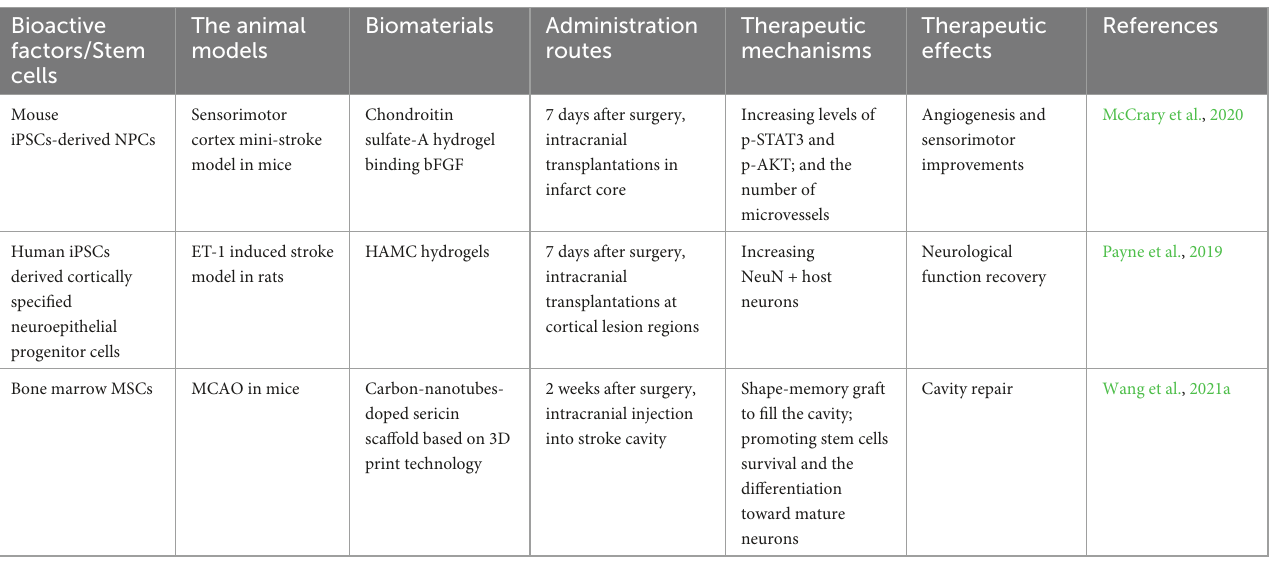
of the damaged BBB (Wang et al., 2019). Immunosuppressants are also the preferred candidates to modulate inflammation after IS (Qiu et al., 2021); for example, mTOR inhibitor